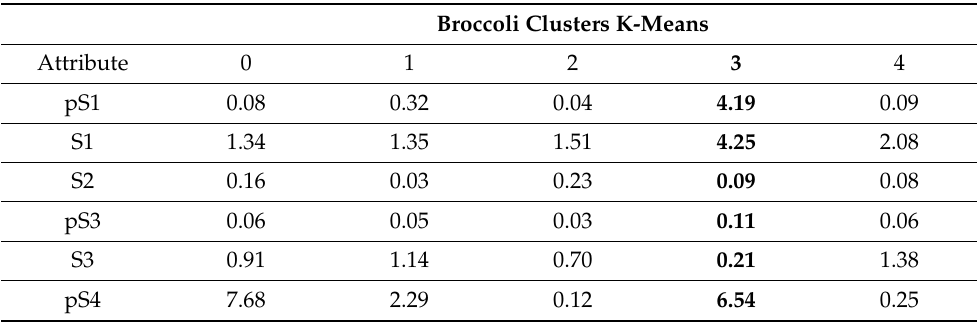
Table 6. K-means clusterization of broccoli production. The units for the i -th stage (pS1, S1, etc.) are in kWh/ton for pt and in ton/h for et in